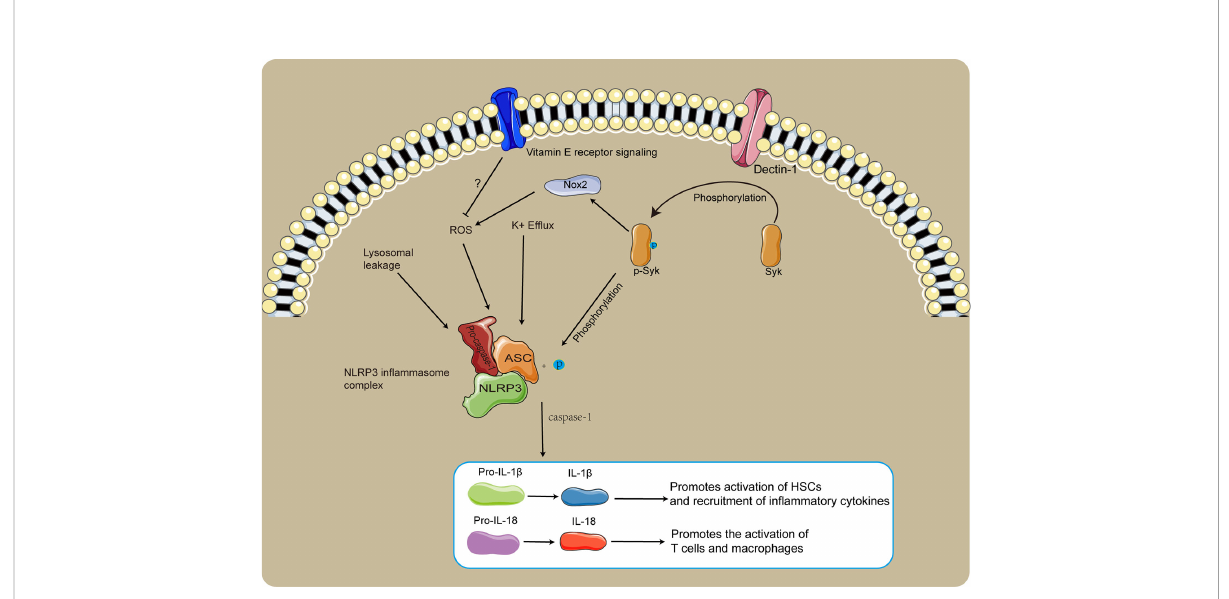
FIGURE 2 The role of NLRP3 in SSLF. The Dectin-1/Syk signaling pathway promotes NLRP3 in fl ammasome activation via phosphorylation of ASC. p-syk dependent NOX2 induced production of ROS facilitates NLRP3 in fl ammasome activation. Vitamin E likely inhibits SSLF by suppressing ROS production and relieving in fl ammatory